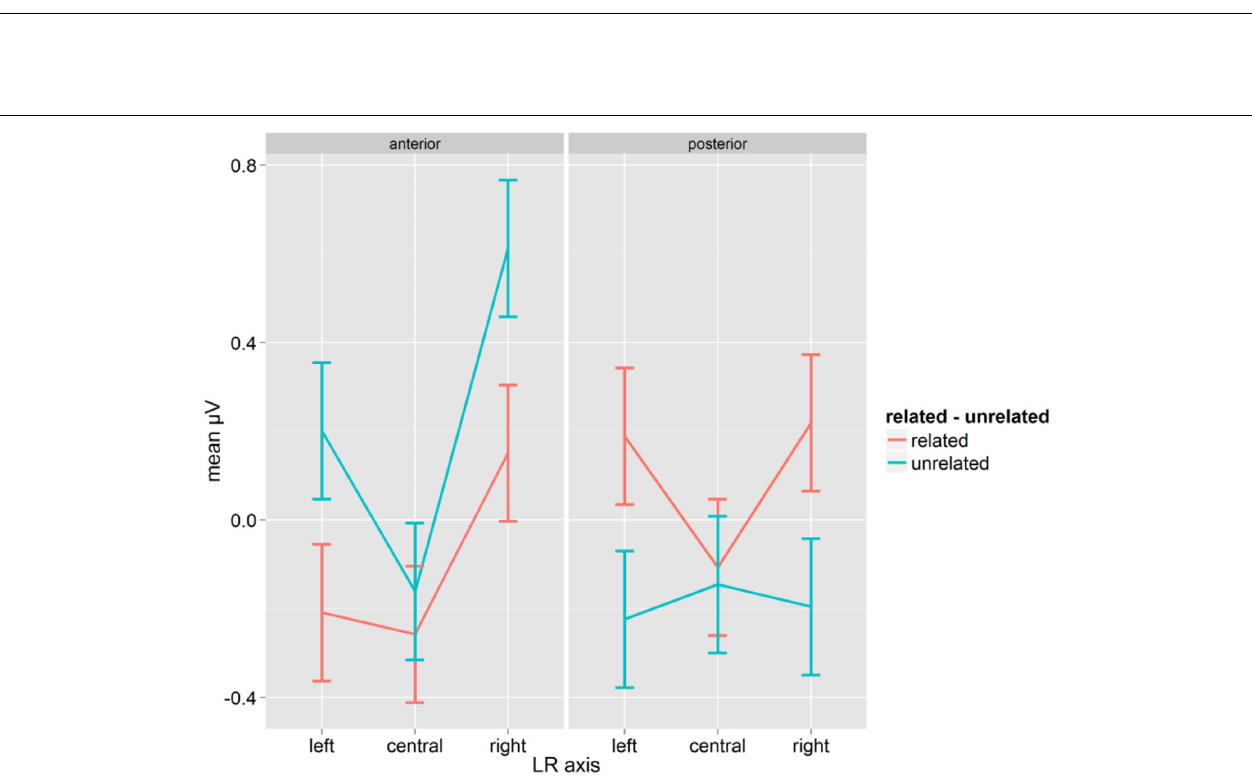
FIGURE 2 | Mean µ V for words as a function of conditions for the time-window 200–300ms; error bars represent Fisher’s least significant differences.